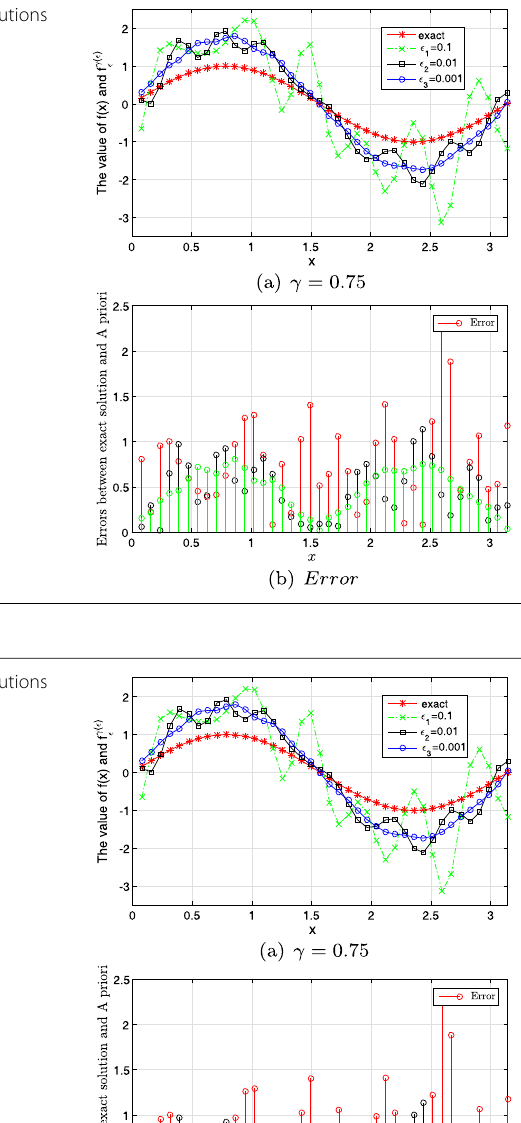
Figure 1 Graph of the regularized, exact solutions and the corresponding errors with γ = 0.75